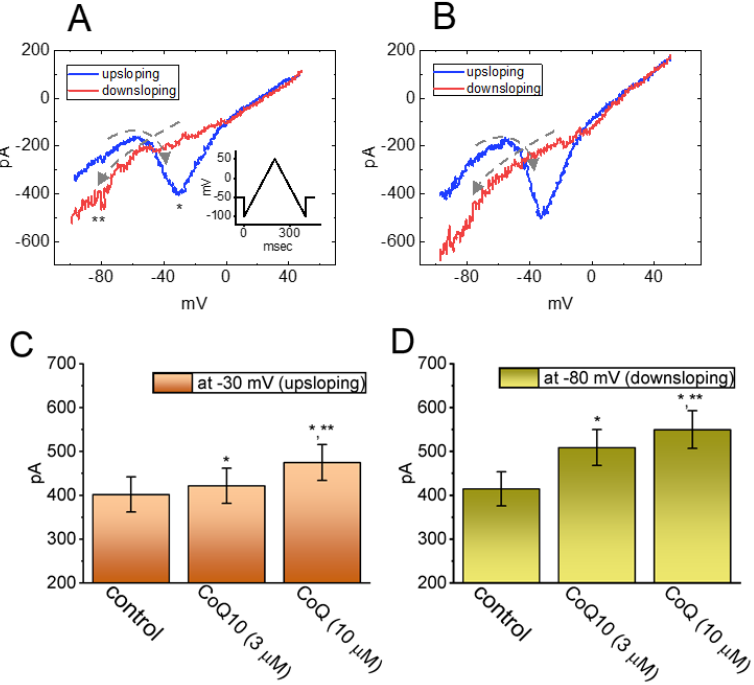
Figure 3. Effects of ubiquinone (CoQ10) on the voltage-dependent hysteresis of the persistent I Na ( I Na(P) ) in GH 3 cells. The cells were bathed in Ca 2+ -free Tyrode’s solution, and the recording pipette was filled with a Cs + -containing solution. When the whole-cell configuration was established, the examined cell was voltage-clamped at − 50 mV, and then an upright isosceles-triangular ramp pulse was applied covering the voltage range from − 100 to +50 mV for a duration of 200 ms (or a ramp speed of ±0.75 V/s). Panels ( A , B ) present representative current traces obtained during the control period and during cell exposure to 3 µ M CoQ10, respectively. The inset in ( A ) shows the voltage- clamp protocol applied. The dashed lines in ( A , B ) indicate the direction of the trajectory of the I Na(P) following the passage of time, indicating a figure-eight configuration of the current. * and ** denote the high-threshold I Na(P) and the low-threshold I Na(P) , respectively, elicited by the ascending (upsloping, in blue color) and descending (downsloping, in red color) limb of a 400 ms-long isosceles- triangular ramp pulse. The summary bar graphs in ( C , D ) depict the effects of CoQ10 (3 and 10 µ M) on the amplitude of the high-threshold I Na(P) and the low-threshold I Na(P) , respectively, in the GH 3 cells (mean ± SEM; n = 8 for each bar). The amplitudes of the high-threshold I Na(P) and the low-threshold I Na(P) activated by a 200 ms-long isosceles-triangular ramp pulse were measured at − 30 and − 80 mV, respectively. * Significantly different from the control group ( p < 0.05) and ** significantly different from the addition of CoQ10 (3 µ M) alone group ( p <